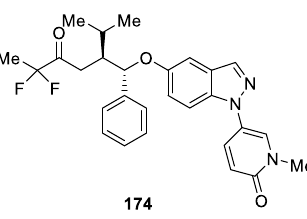
Figure 55. Chemical structure of 1 H -indazole derivative 174.